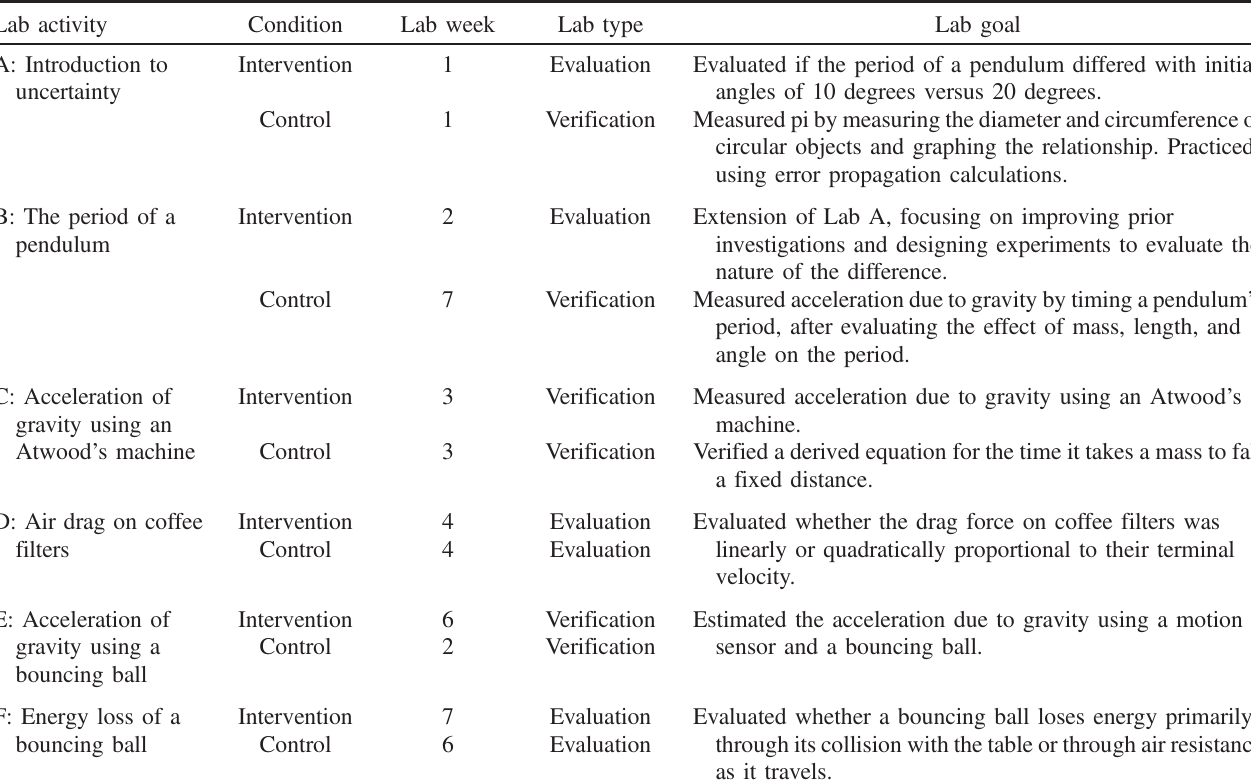
TABLE II. Lab activities performed by the students in both the control and intervention conditions, with differences in the lab week, type, and goal